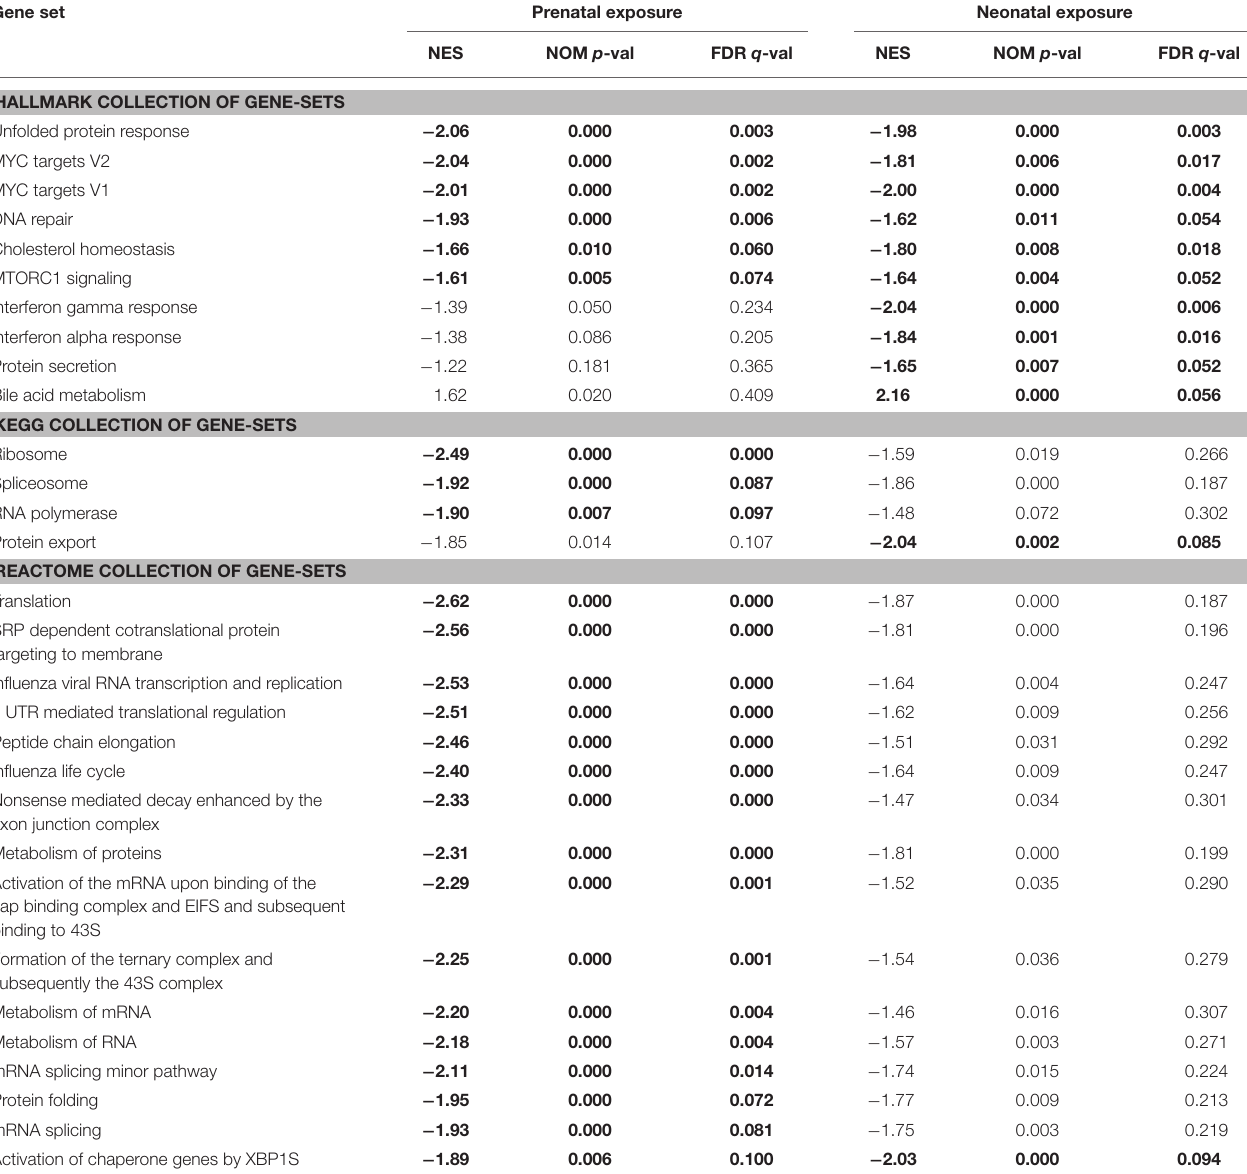
TABLE 3 | Top GSEA enriched gene-sets in livers of 10 months old mice exposed pre- or neonatally to BDE-47. Gene